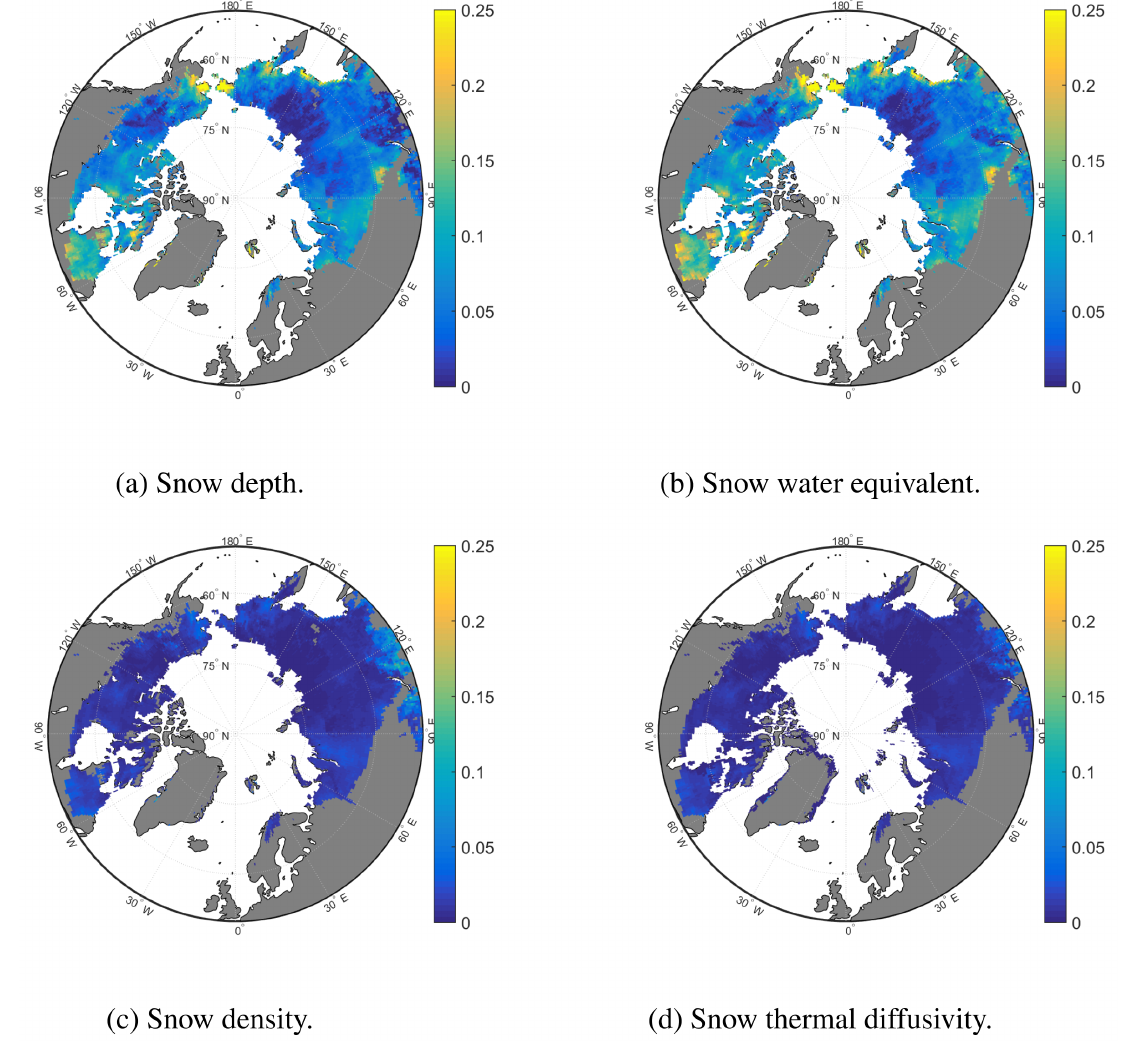
Figure 6. Comparison of mean winter (DJF) season snow properties during 1980–2009. Shown is the relative difference (REDVAR − CNTL)/CNTL expressed as a fraction